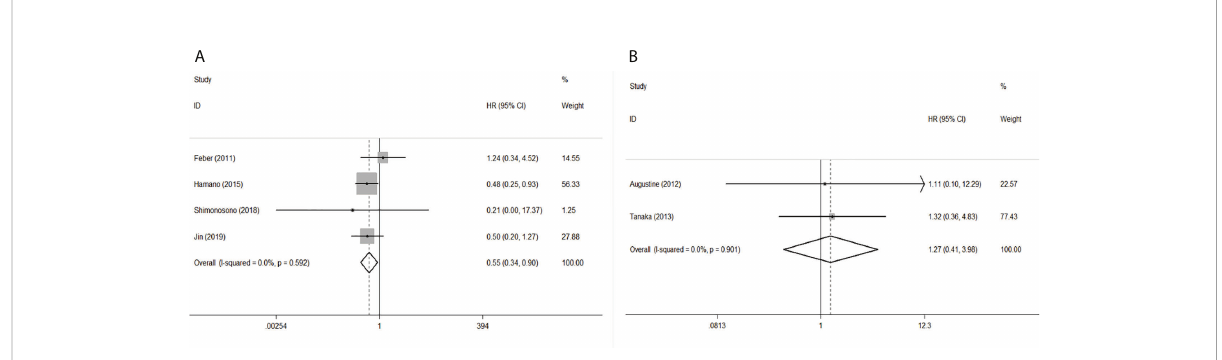
FIGURE 4 Forest plot of pooled HR of mir-145 in predicting survival outcomes in EC. (A) mir-145 and OS. (B) mir-145 and